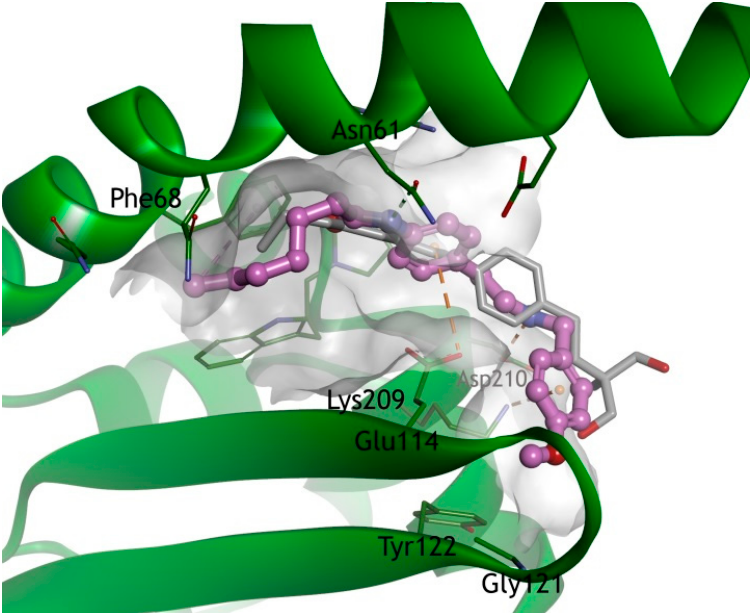
Figure 4. Docking model of FTY720 ( 1 , gray, ball and stick) and compound 7 (purple, ball and stick) in the I2PP2A/SET. The X ‐ ray structure of IPP2A/SET was obtained from the Protein Data Bank (PDB code 2E50). The I2PP2A/SET is represented by a blue ribbon model. The hydrogen bonds are shown as a green dashed line, and an orange dashed line represents electrostatic interactions. Also, the hydrophobic interactions are shown as a pink dashed line.